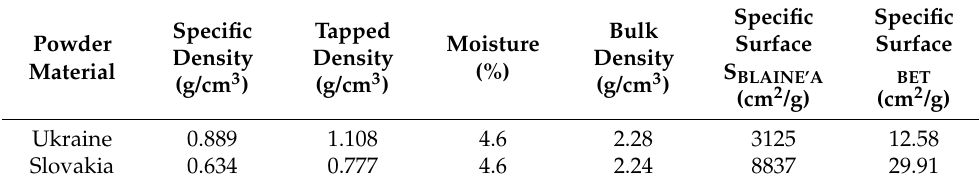
Table 2. Physical properties of powder materials from Ukraine and Slovakia.